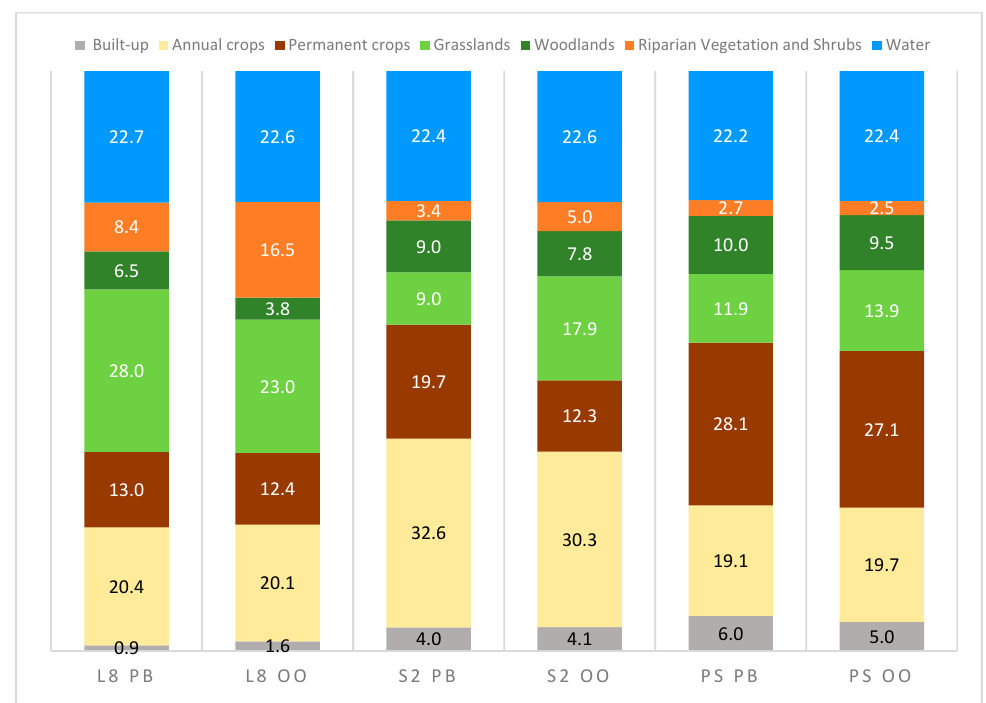
Figure 5. Percentages of the total area occupied by the LULC classes in the selected classifications (L8: Landsat 8, S2: Sentinel 2; PS: PlanetScope; PB: pixel-based; OO: object-oriented).